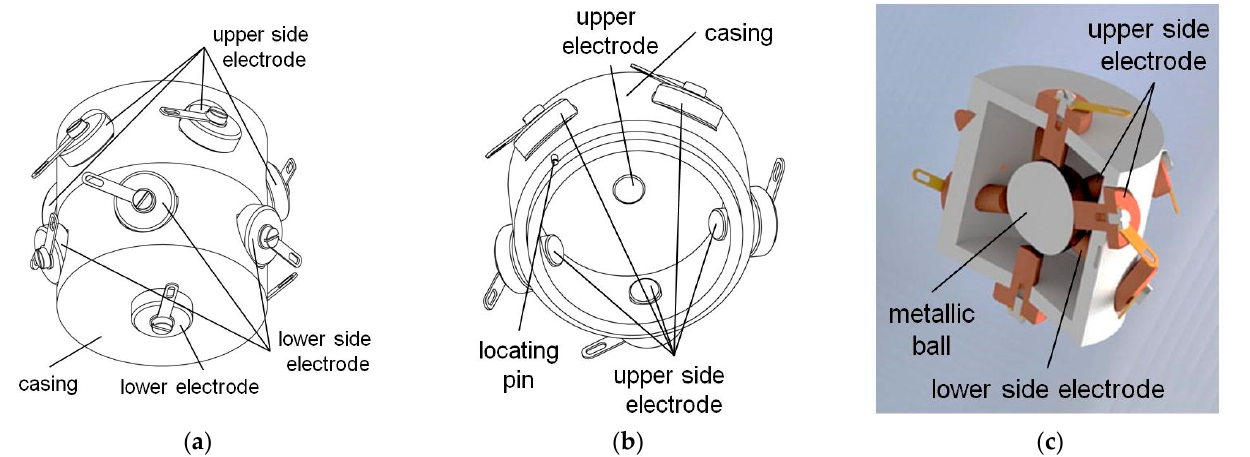
Figure 13. Dodecahedral tilt sensor: ( a ) perspective view; ( b ) inside chamber; ( c ) establishing of electric contact (short-